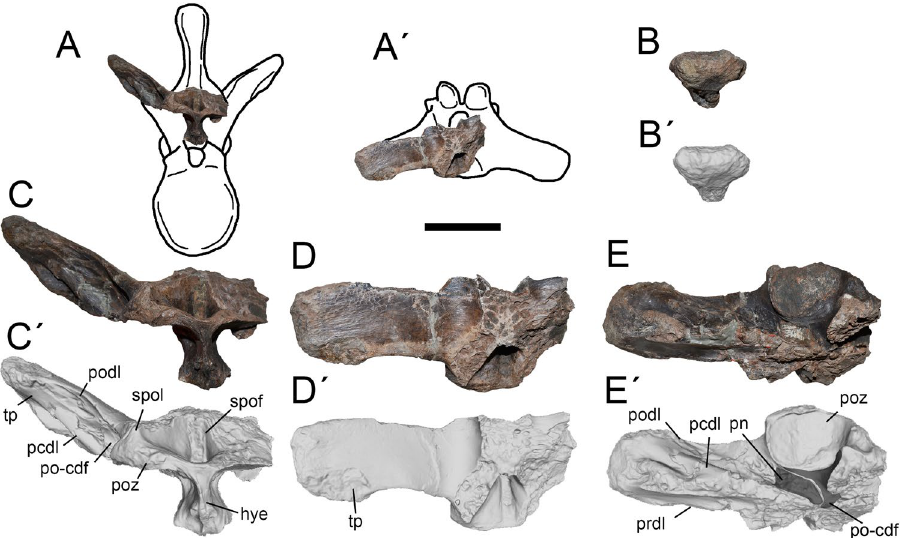
Figure 6. Seventh dorsal of Maip . Interpretative drawing showing the preserved parts ( A , A´ ), lateral ( B , B´ ), posterior ( C , C´ ), dorsal ( D , D´ ) and ventral ( E , E´ ) views. Scale bar: 5 cm. Abbreviations: hym, hypantrum; pn, pneumatopore; pcdl; posterior centrodiapophyseal lamina; podl; postzygapophyseal lamina; poz, postzygapophyses; po-cdf; postzygapophyseal-centrodiapophyseal fossa; prdl; prezygodiapophyseal lamina; spof; spinopostzygapophyseal fossa; spol; spinopostzygapophyseal lamina; tp, transverse